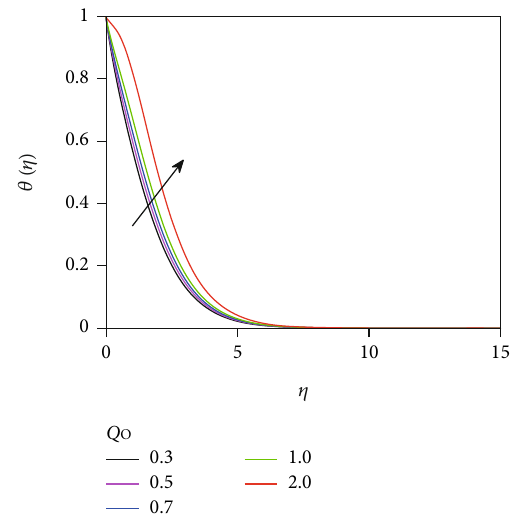
Figure 7: Signi fi cance of the heat generation on temperature